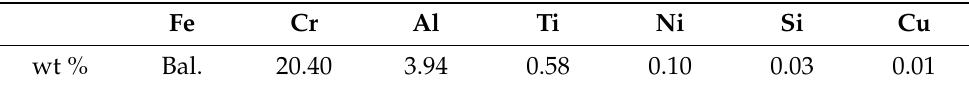
Table 1. Chemical composition of the PM2000 alloy as measured by XRF (only elements present in an amount ≥ 0.01 wt % are shown)